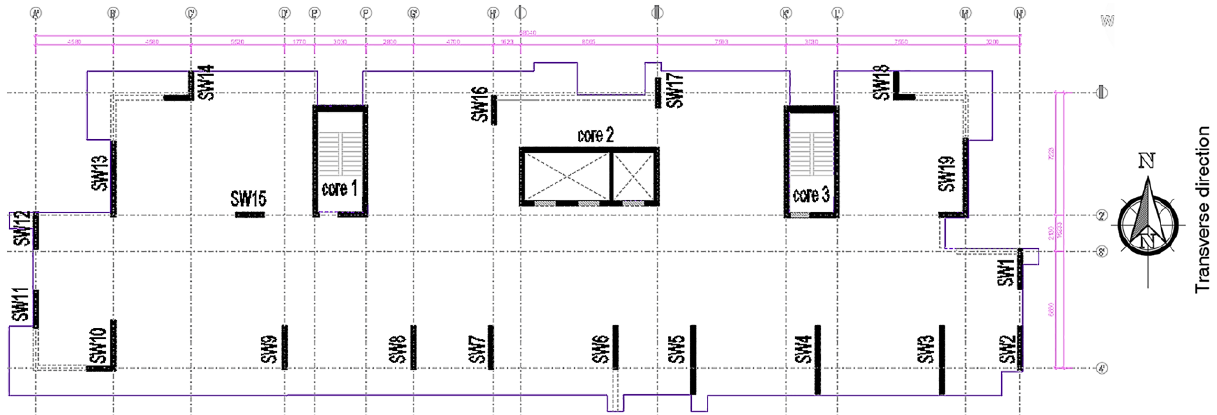
Figure 2. Plan view of the labeled-shear-wall layout for typical